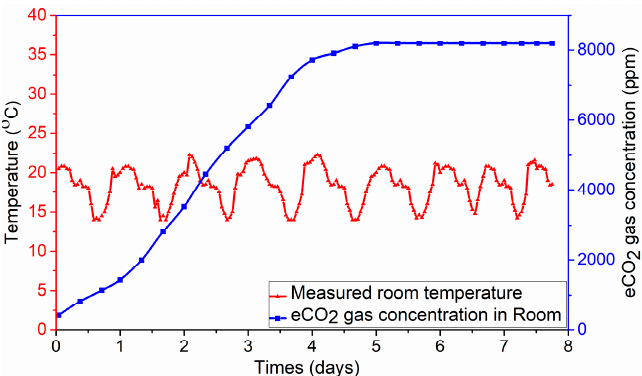
Figure 12. Food monitoring experimental results of measuring temperature and eCO 2 gas concentrations in room environments.